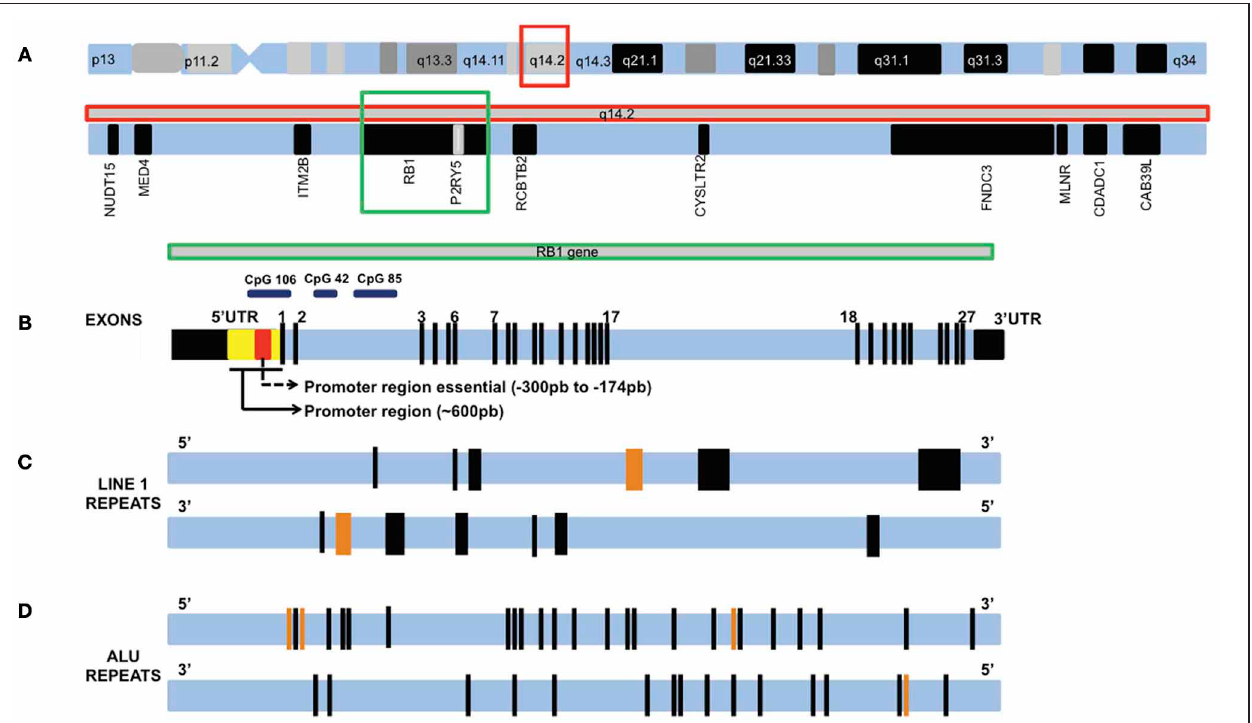
island, like CpG 106, CpG 42, and CpG 85. (C) A pair of horizontal lines showing the location of LINE1 repeats in RB1 gene oriented in the sense direction (top line) and antisense direction (bottom line). Each black bar represents one LINE1, orange bars represent two LINE1 repeats. The bar thickness is proportional to the size of the sequence. (D) A pair of horizontal lines showing the location of ALU repeats in RB1 gene oriented in the sense direction (top line) and antisense direction (bottom line). Each black bar represents one ALU repeat, orange bars represent two ALU